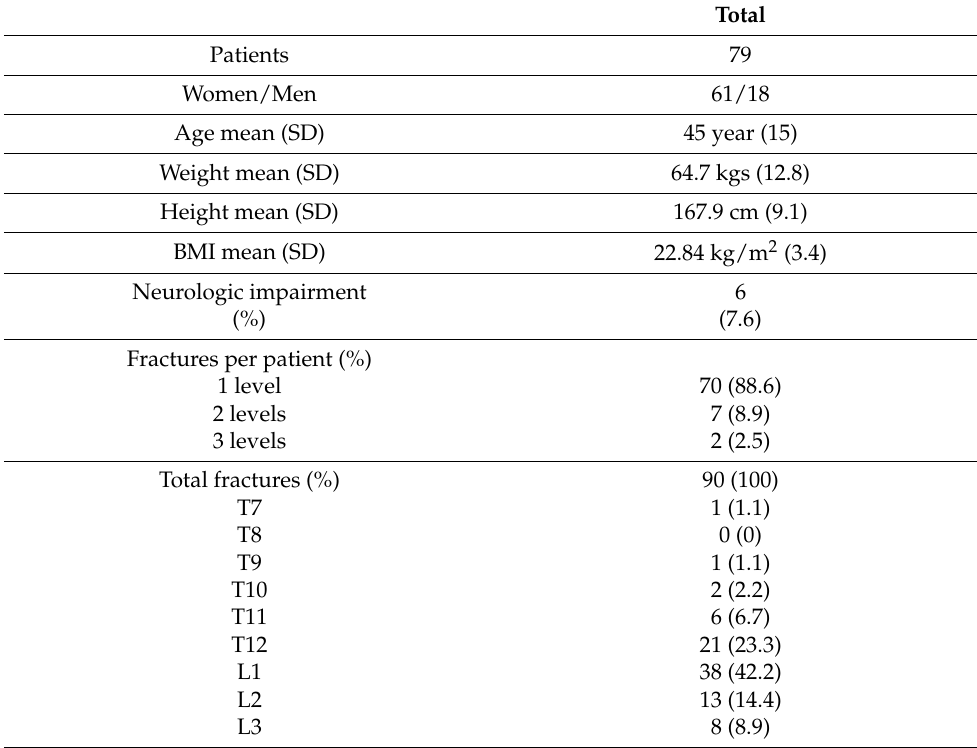
Figure 1. Evolution of retrieved patients per year. Table 1. Demographical